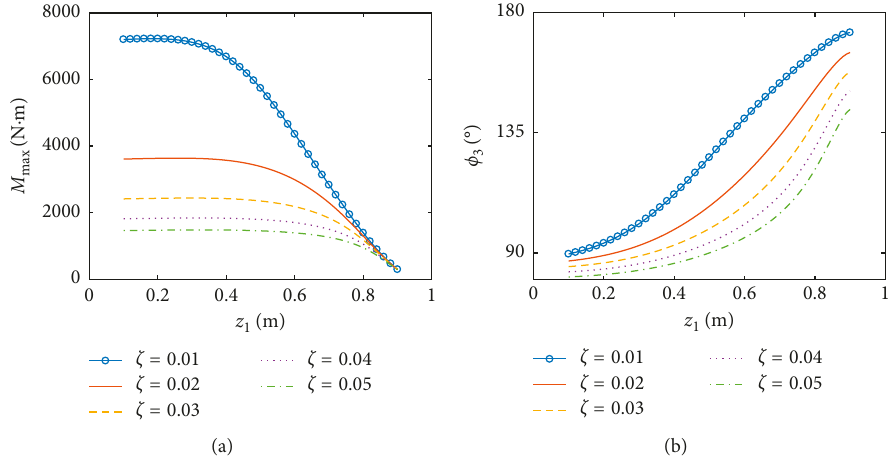
Figure 14: The amplitudes and the phases of resultant moment versus the position of the flexible baffle for R amplitude of the resultant moment, (b) the phase of the resultant